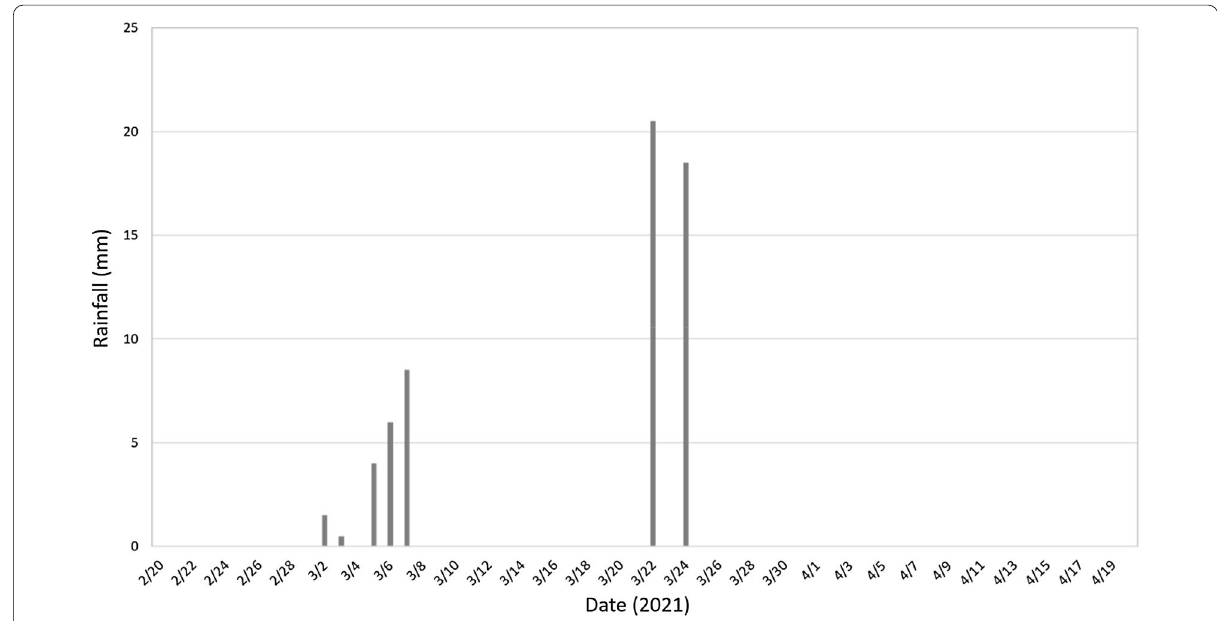
Fig. 5 The daily rainfall records from 2/20 to 4/19 in the study area